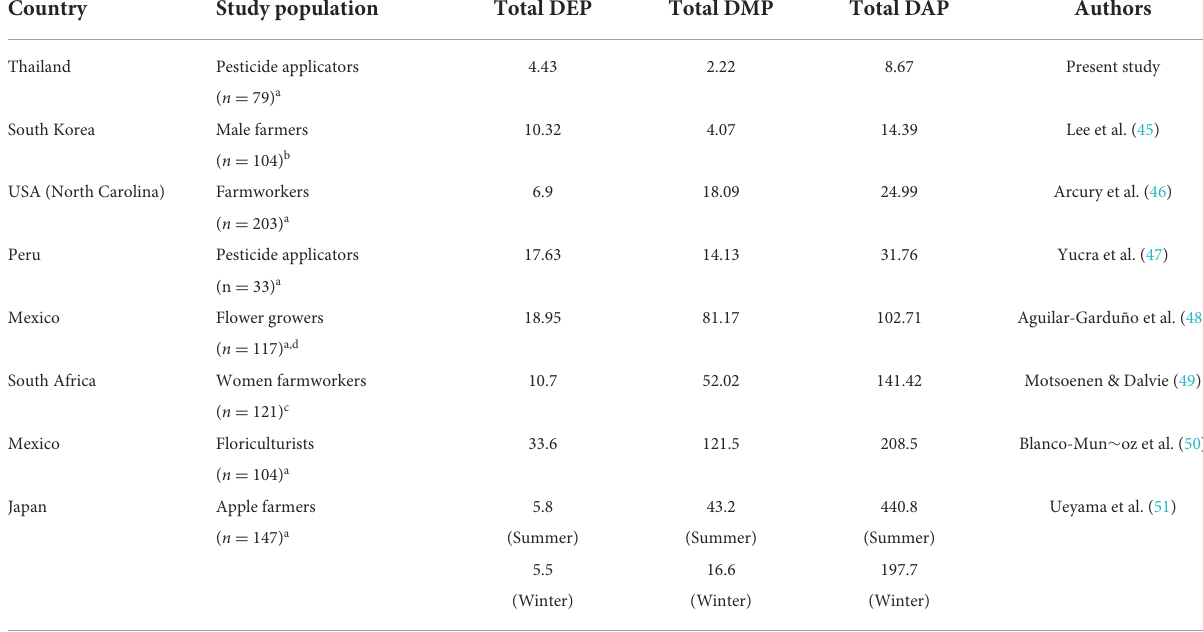
TABLE 6 Urinary OP metabolite levels ( µ g/g creatinine) in other countries.